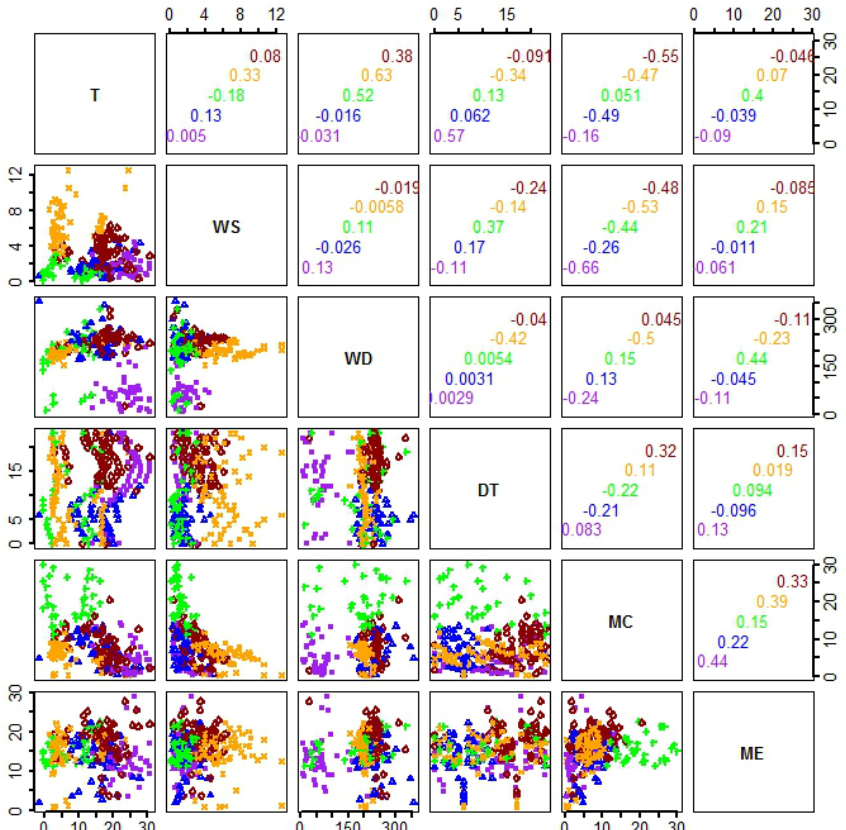
Figure 5. Clustering of air temperature (T) in ◦ C, wind speed (WS) in ms − 1 , wind direction (WD) in ◦ , daytime (DT) in h, CH 4 concentration (MC) in ppm and CH 4 emission (ME) in gh − 1 LU − 1 in the data set of the solid floor system in Switzerland. The abbreviations on the diagonal indicate which variables are displayed at the axes in the respective row and column of the plot. Cluster affiliation is color-coded in the scatter plots in the lower triangle in violet, blue, green, orange and red (ordered from low median of emission to high median of emission in the cluster). The upper triangle shows the related Spearman’s rank correlation values for the individual clusters in the same color